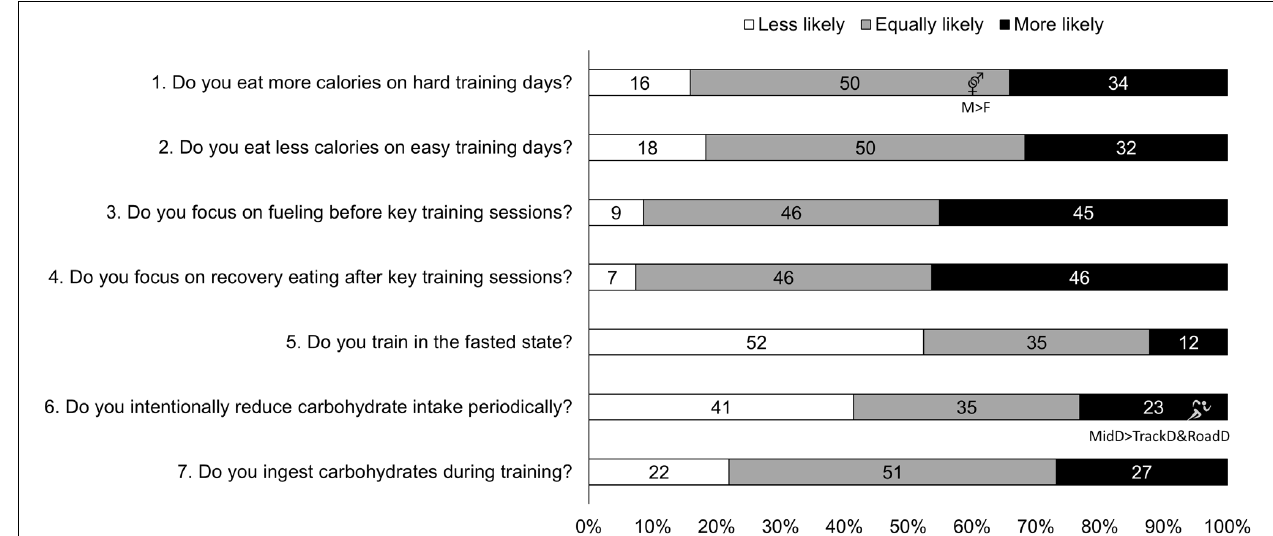
FIGURE 8 | C: Major nutrition strategies implemented during competition season and preparation for competition as compared to base/endurance phase. Answers to Part C: “Compared to nutrition during base/endurance training phase, how much do you focus on the following dietary strategies during competition season (track athletes) or preparation for competition (road athletes)?” Values are percentages of all athletes ( n = 83): white bars , less likely; gray bars , equally likely; black bars , more likely to follow this strategy. Symbols have been used to reflect significant ( p < 0.05) between-group differences between sexes ( vector sex symbol ), and distance event ( runner symbol ). Where significant differences were detected, the symbols are combined with a brief description of direction of difference, for example, M > F reflects a higher % of males (M) compared to females (F) for that answer. MidD , Middle Distance (800 and 1500 m); TrackD, track distance (3000 m steeplechase to 10,000 m); RoadD , road distance (marathon and race walks).